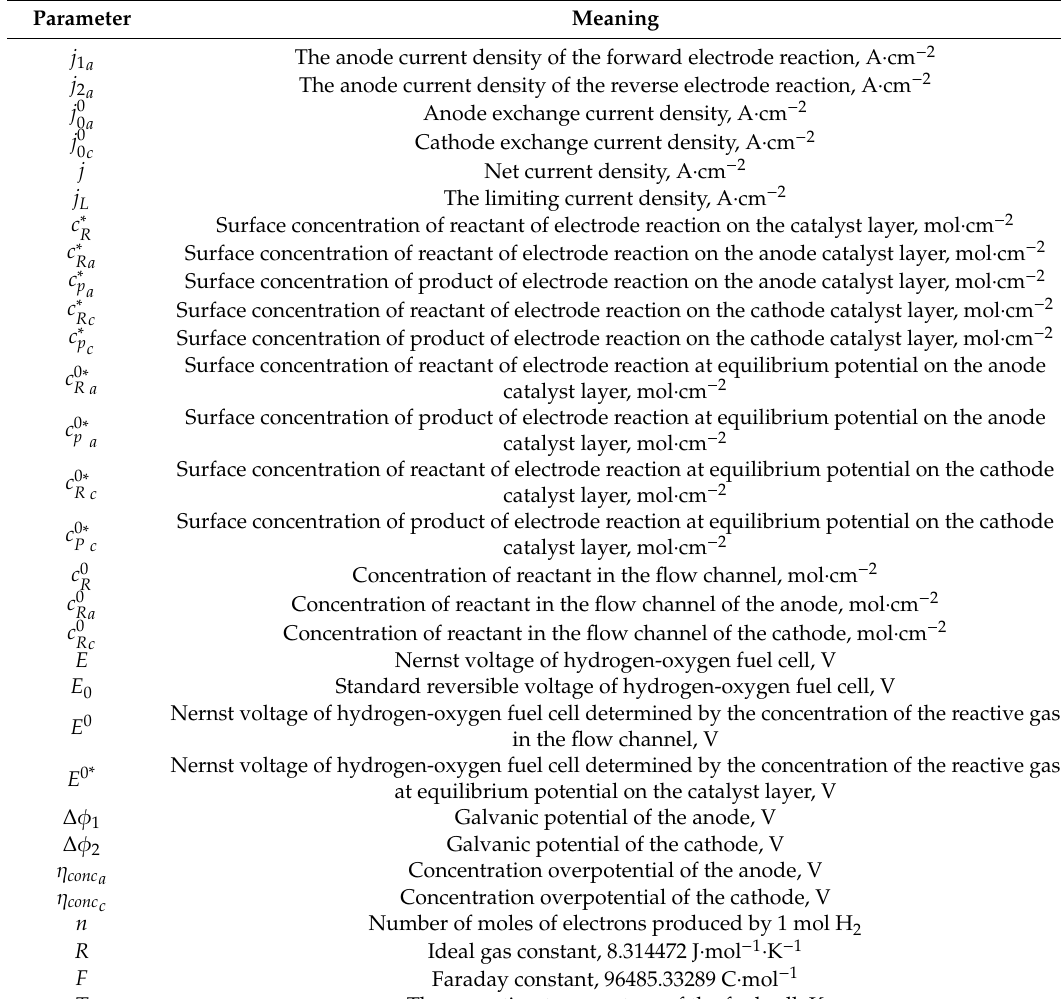
Table 1. Parameters used for modeling the hydrogen-oxygen fuel